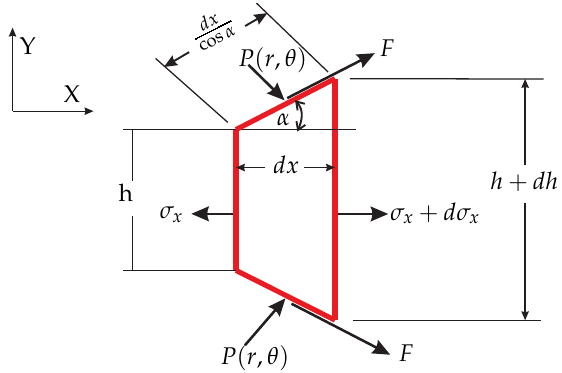
Figure 7. Loads on slab element